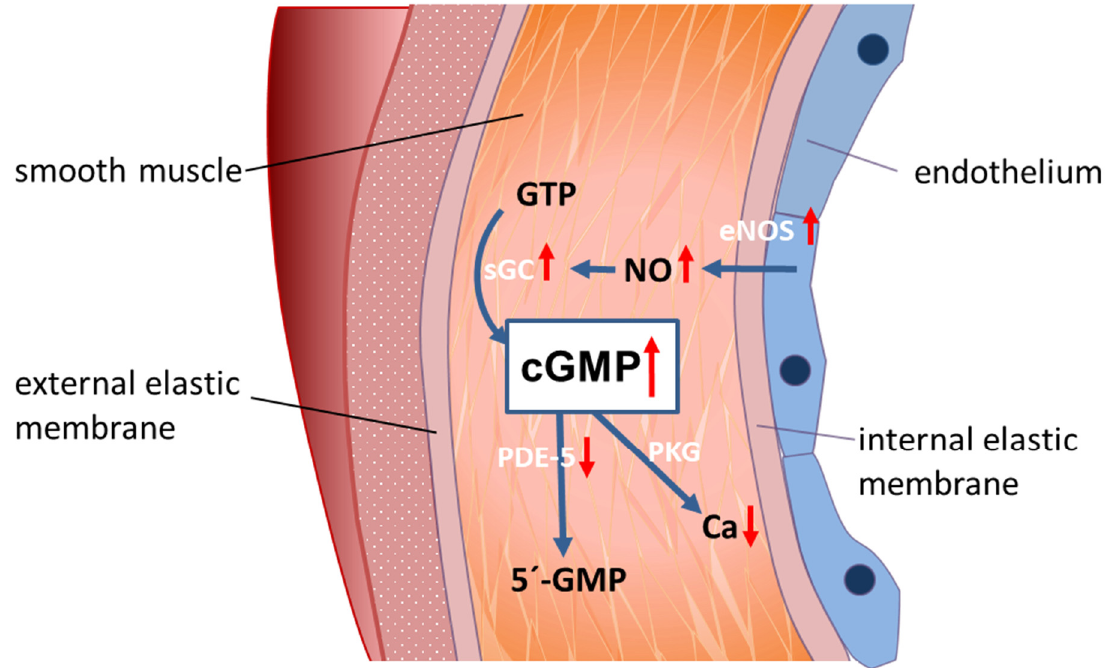
Figure 5. A model for peripheral vasodilation in progressed liver cirrhosis. In liver cirrhosis, NO is overexpressed in periph- eral arterial blood vessels, while PDE-5 is decreased. This leads to high cGMP concentration and peripheral